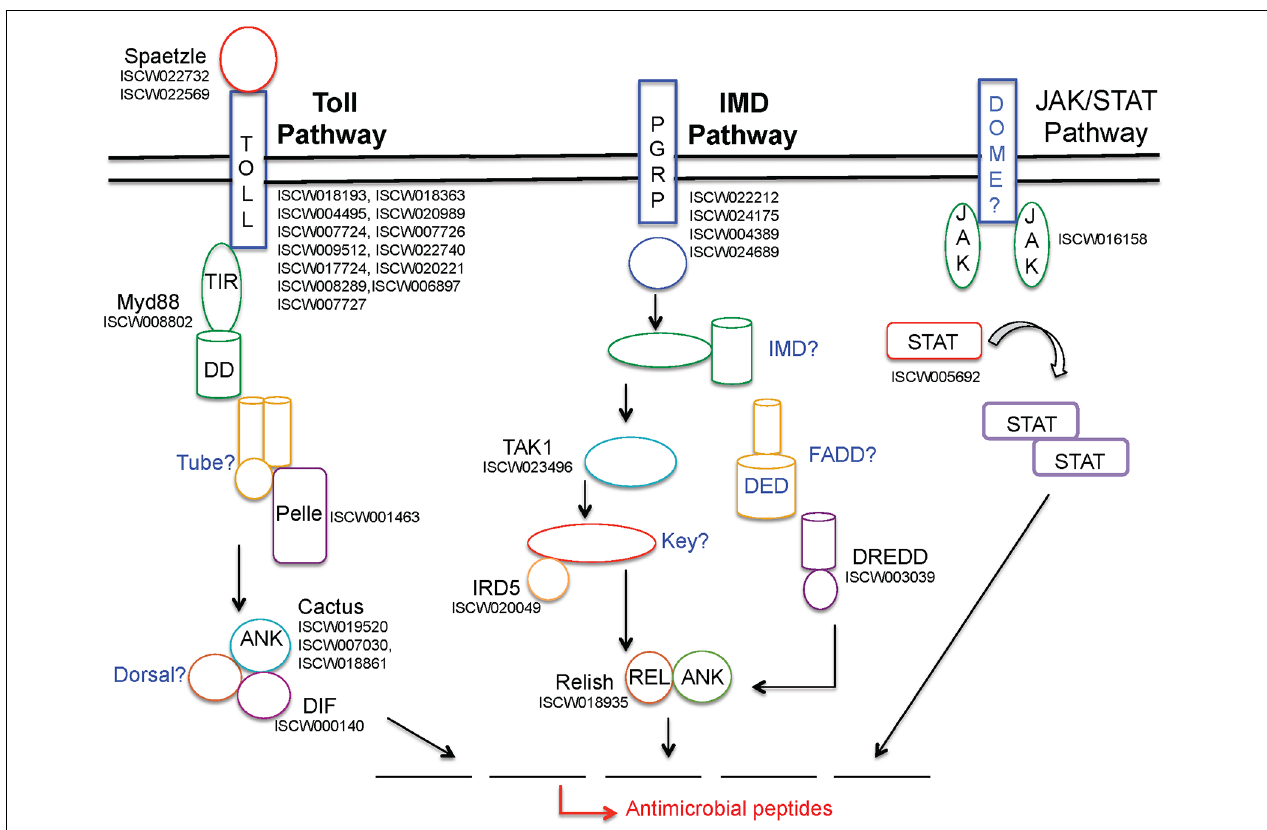
FIGURE 1 | Schematic representation of I. scapularis immune-related genes potentially representing three major signaling pathways that lead to anti-microbial responses. While annotated tick genes from each pathway